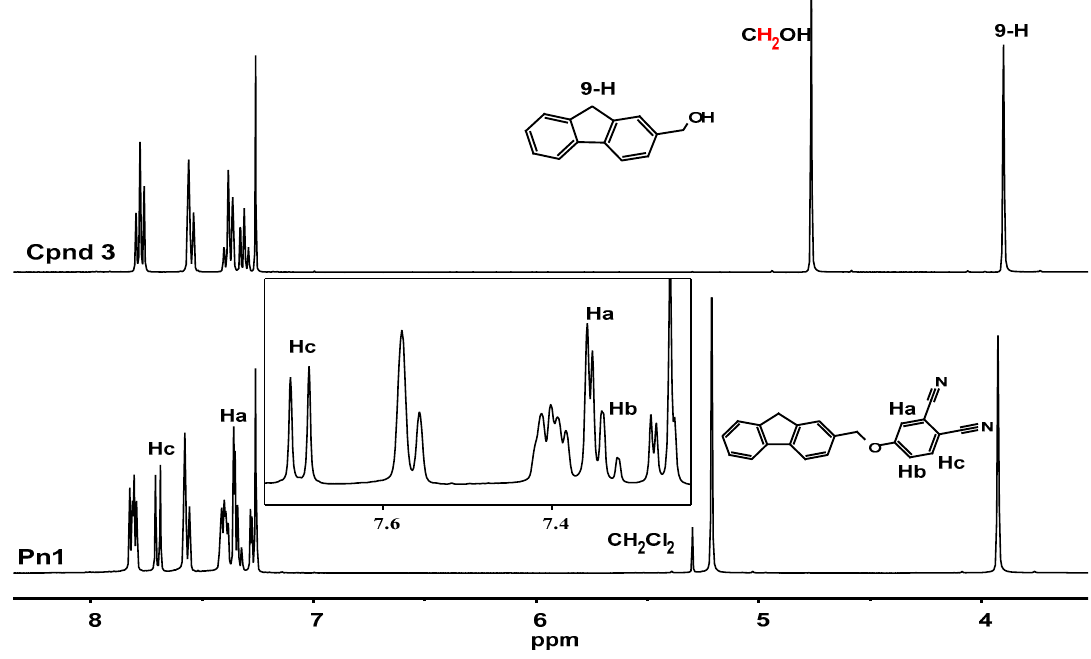
Figure 5. Comparison of the 1 H-NMR spectra of the precursor 3 and Pn1 in CDCl 3 .